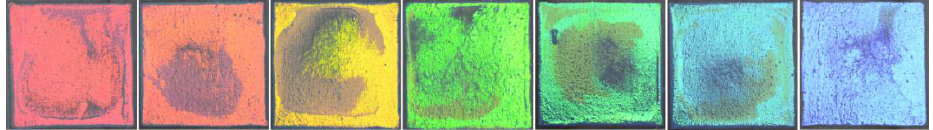
Figure 14. Photos of PSt microspheres self-assembled into coatings on wood surfaces.